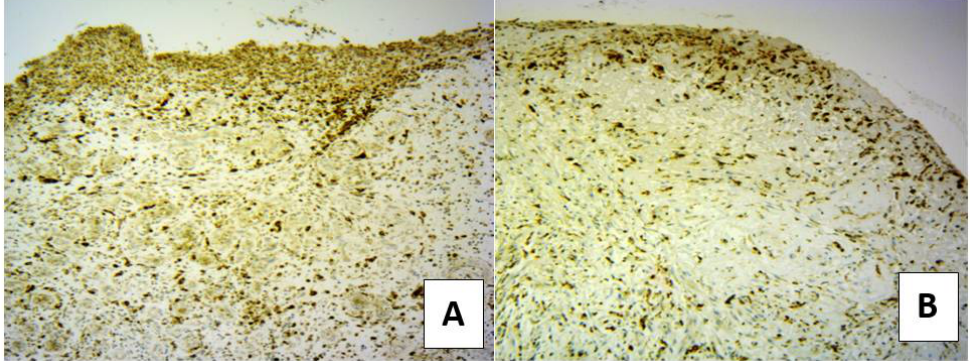
Figure 4. Distribution of CD68 + M1 macrophages in the ulcer bed on day 14 of treatment. Immunostaining to CD68 + cells in biopsies of patient with SuDe ( A ) and SuDe + Lp ( B ) treatment. Photos were taken with 20× objective.